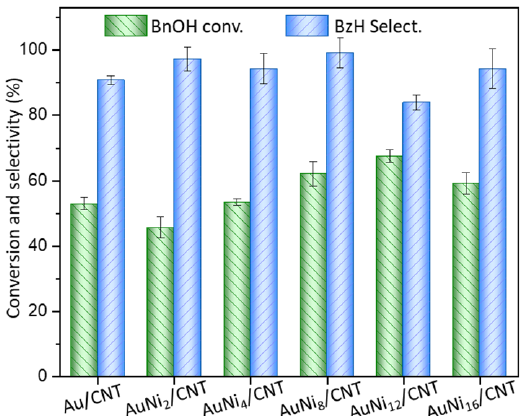
Figure 1. Catalytic performances of Au/CNT promoted by Ni-containing species. Reaction condi- tions: 50 °C for 3 h, O 2 flow rate of 40 mL/min, 10 mg catalyst, alkali/BnOH = 0.42:1, BnOH/Au = 650:1 (molar ratio). BnOH—benzyl alcohol, BzH—benzaldehyde.